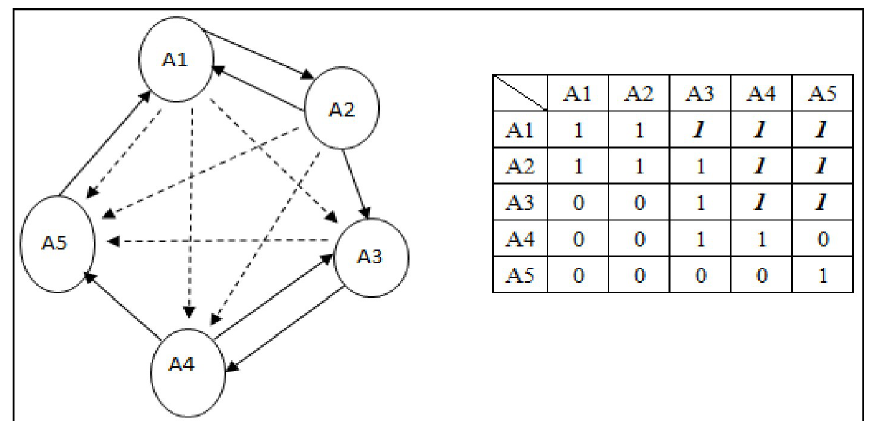
Fig 2. Influence relation and reachability matrix after transitivity check and conversion.